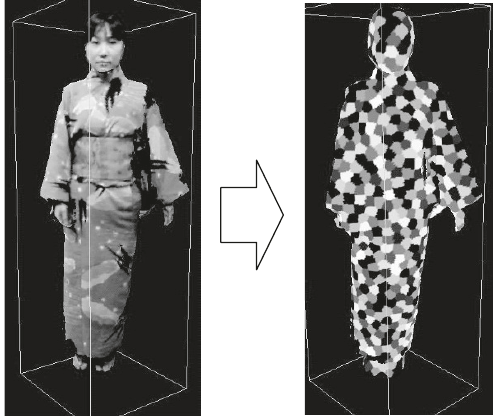
Figure 3: Concept of modified shape distribution. Vertices of 3D model are firstly clustered into 1024 groups by vector quantization in order to scatter representative vertices uniformly on 3D model